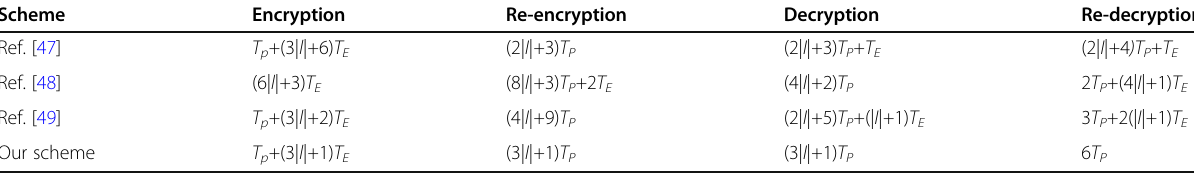
Table 4 Comparison of computational overhead